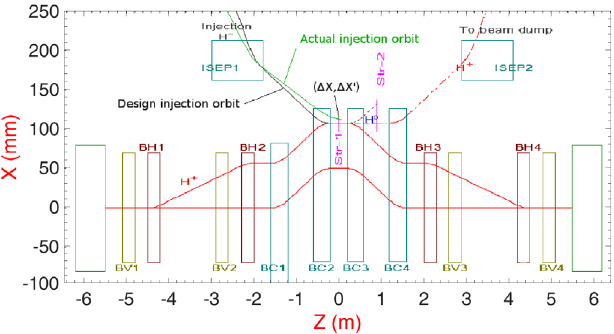
FIG. 2. Schematic layout of the injection system.